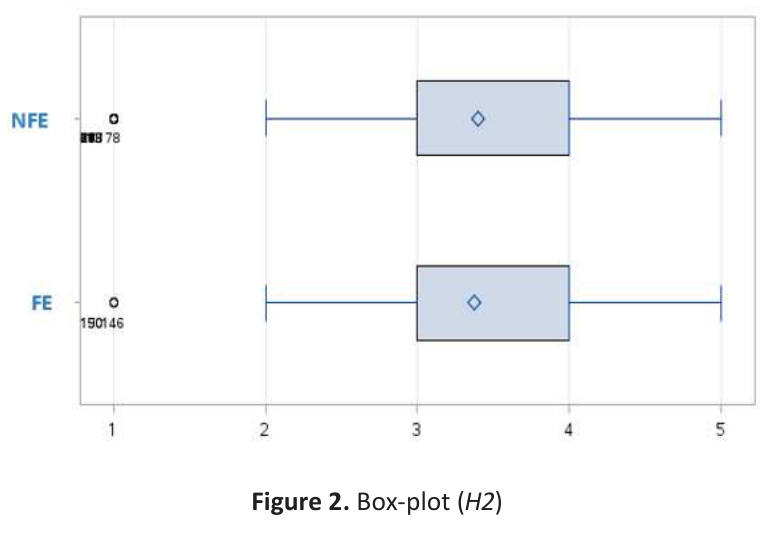
Figure 1. Box-plot ( H1 )